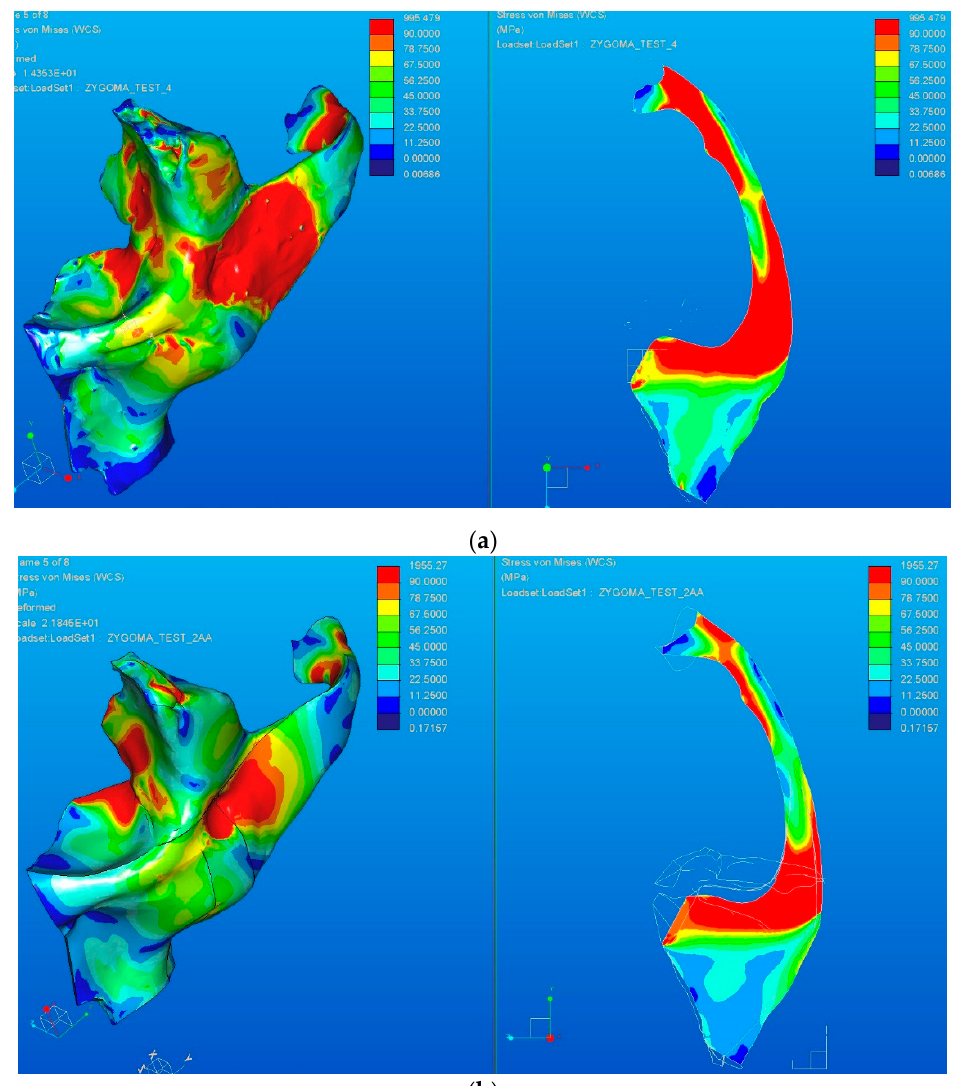
Figure 18. Von Mises stress distribution: ( a ) for the CATIA model; ( b ) for the Creo model.